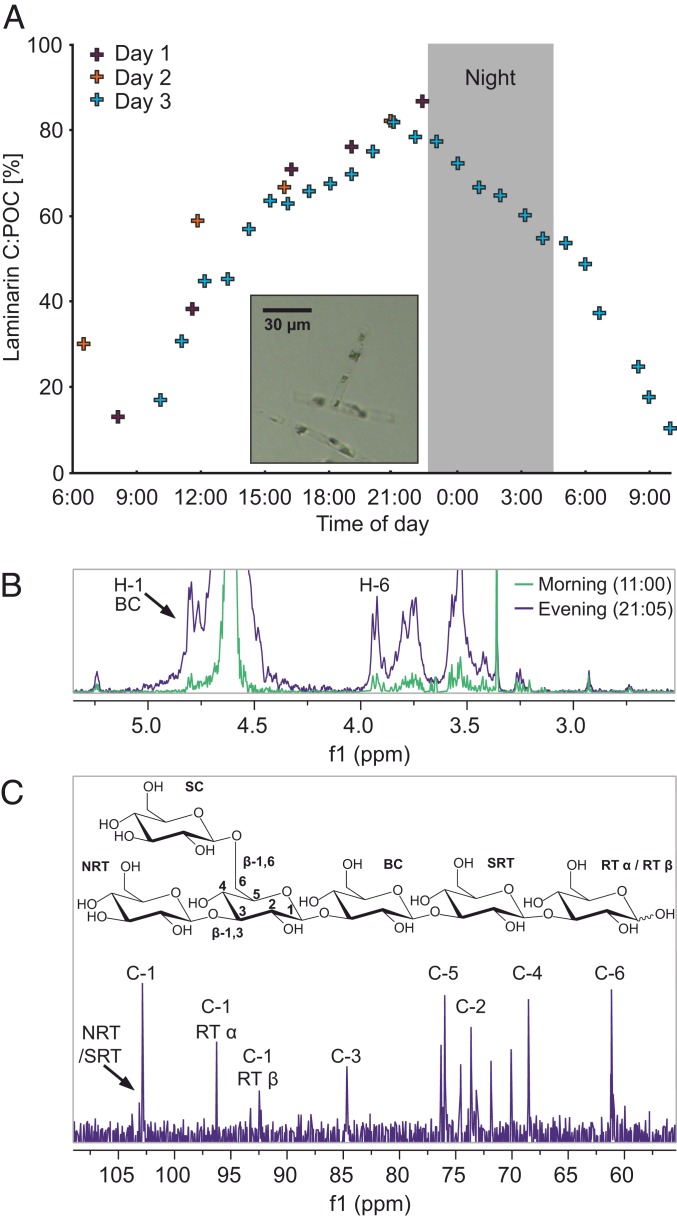
Diel-laminarin-cycling in the particulate organic carbon pool. (A) The scatter plot depicts the dataset of laminarin carbon per POC (LamC:POC) in % against the time of day. The gray area marks the time of sunrise and sunset. The sampling took place in spring 2018 during 3 d in the Raunefjorden near Bergen, Norway. On day 3, the sampling was conducted every hour for 24 h. The Inset shows a representative photograph of chain-forming diatoms that dominated the algal bloom. (B) 1H NMR spectra from two time points at 11:00 (green) and 21:05 (purple) showing the anomeric H-1 doublet of the backbone chain (BC) and H-6 (5 mg⋅mL−1 in D2O recorded at 600.2 MHz, 313 K, spectra normalized on the area of the ISTD). (C) 13C NMR spectrum of the 21:05 sample (250 mg⋅mL−1 in D2O recorded at 150.94 MHz, 313 K). POC filters were extracted with water at 60 °C. NRT(SRT), (second next to) nonreducing terminus.